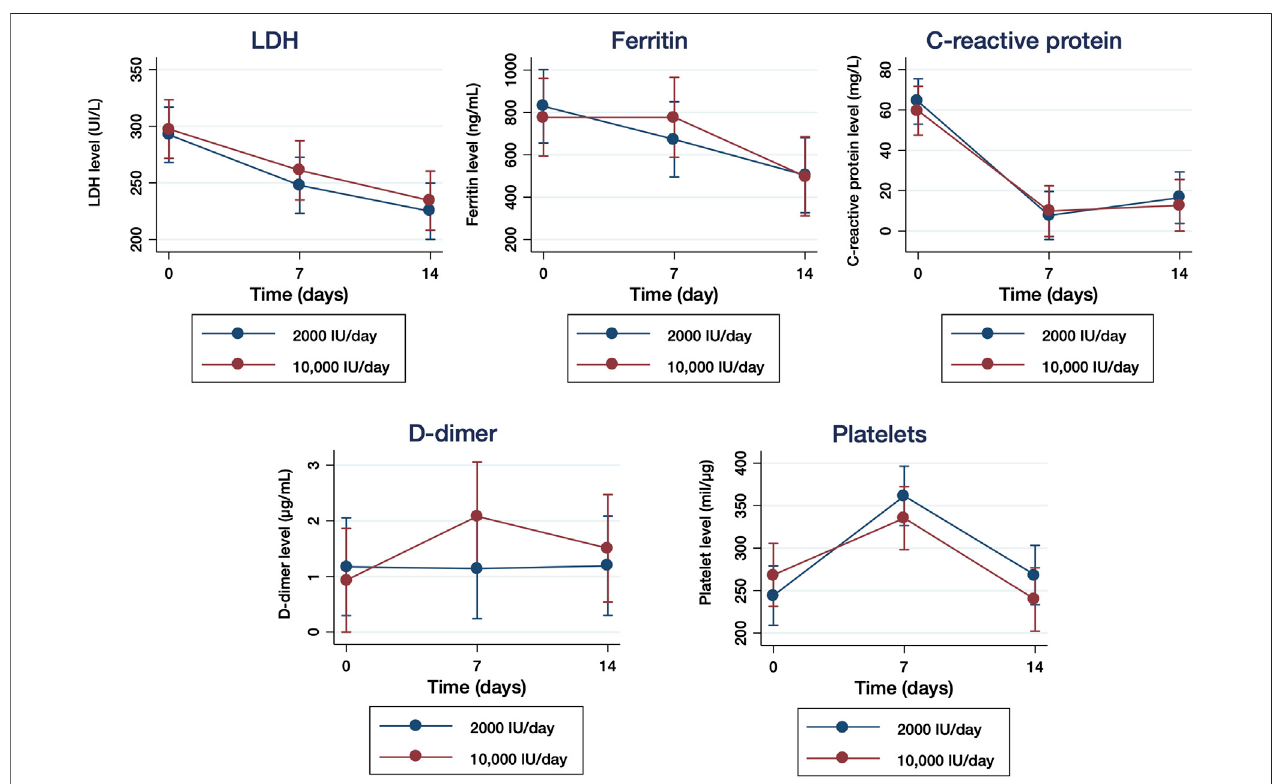
FIGURE 4 | Serological biomarkers related to the in fl ammation in samples of hospitalized patients with COVID-19 who received 2000 IU/day and 10,000IU/day of cholecalciferol.Levels(U/L)oflactatedehydrogenase(LDH) (A) ,levels(ng/ml)offerritin (B) ,levels(mg/L)ofC-reactiveprotein[CRP] (C) ,levels(µL/ml)ofD-Dimer (D) and platelet count (mil/µl) (E) were quanti fi ed at baseline (day 0), 7 and 14 days of treatment. The results are presented as means ±95% of con fi dence intervals.